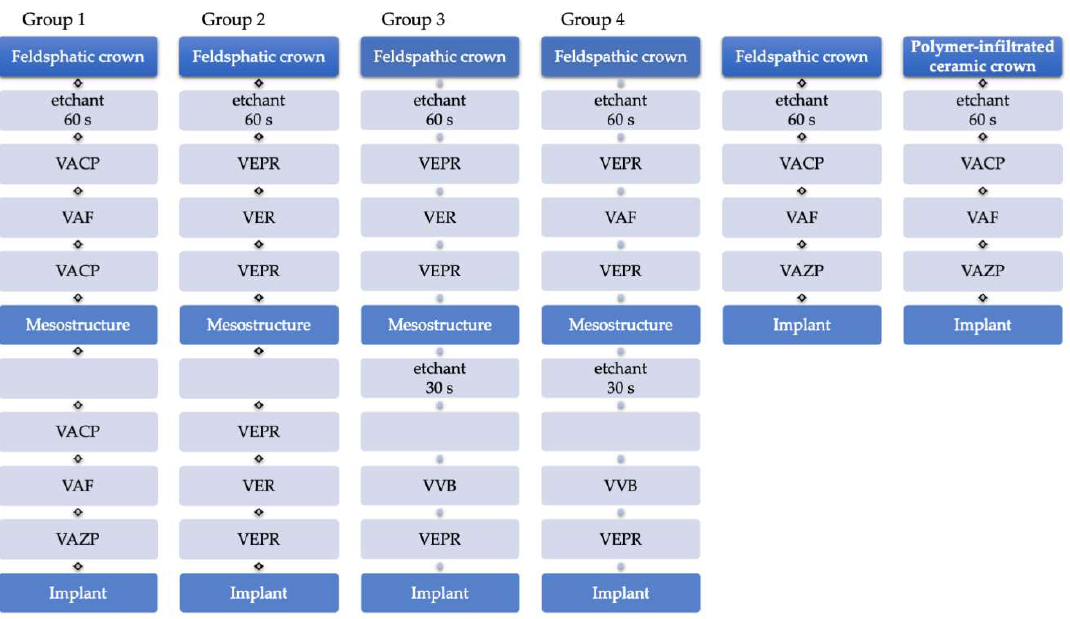
Figure 2. Test matrix describing the cementation procedure of mesostructures on implants and feldspathic crown on mesostructures (Group 1–4) and the cementation of monolithic feldspathic crowns and polymer infiltrated network crowns on implants. n = 16 per test-group; 8 initial, 8 aged.